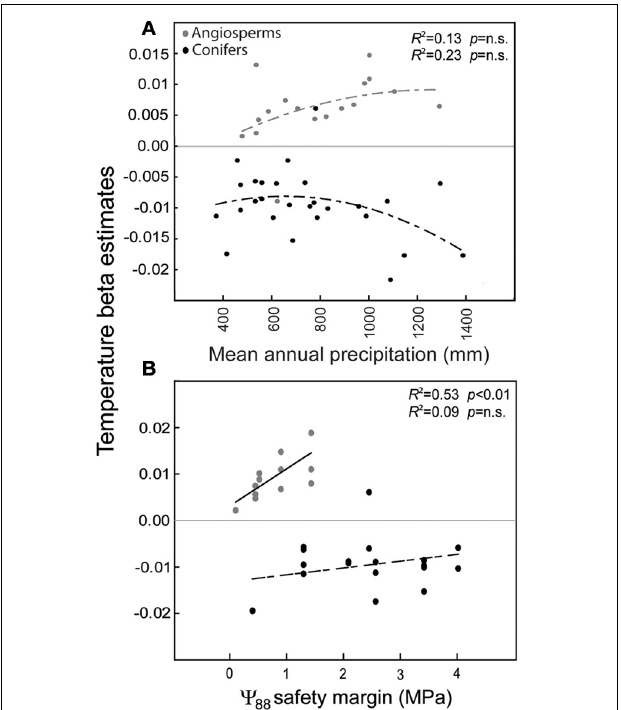
FIGURE 1 | Summary of the variation in the effect of temperature on tree growth along a rainfall gradient (A) and across interspecific differences in hydraulic safety margins (B) in conifers (black dots) and angiosperms (gray dots). The tree species included in the analysis are: Fagus sylvatica, Quercus ilex, Q. pubescens, Q. pyrenaica, Q. robur, Abies alba, Pinus halepensis, P. nigra, P. pinaster, P. pinea, P. sylvestris, and P. uncinata. P. radiata and Q. suber were only included in panel (A) due to a lack of data for hydraulic safety margins. Coll et al. (2013) applied generalized linear models (GLM) to study tree growth responses (dependent variable) and assessed the following independent predictors: (i) climate and topography (Emberger water deficit index, mean annual temperature, terrain slope), (ii) forest stand structure (tree density, basal area), (iii) soil (organic layer depth), (iv) individual tree traits [tree height, diameter at breast height (DBH)], and (v) management practices (e.g., plantations). Beta estimates in panels (A) and (B) show the reported significant effects of temperature on tree growth in GLM analyses (Coll et al., 2013). n.s. means not significant.